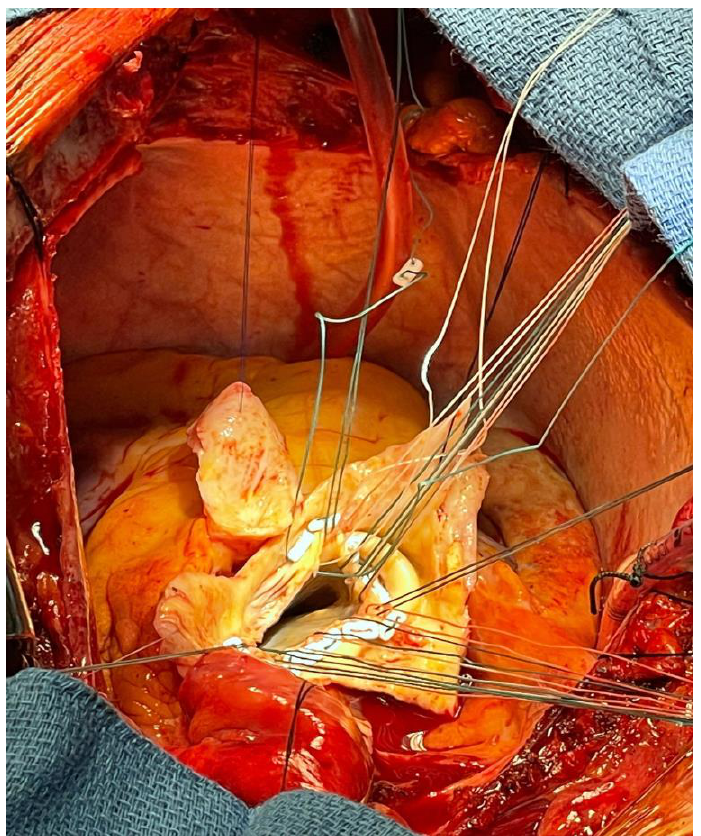
Figure 6. Real picture of Bentall intervention for type A aortic dissection complicated by aortic valve regurgitation, showing ascending aorta resection and aortic valve exposure.